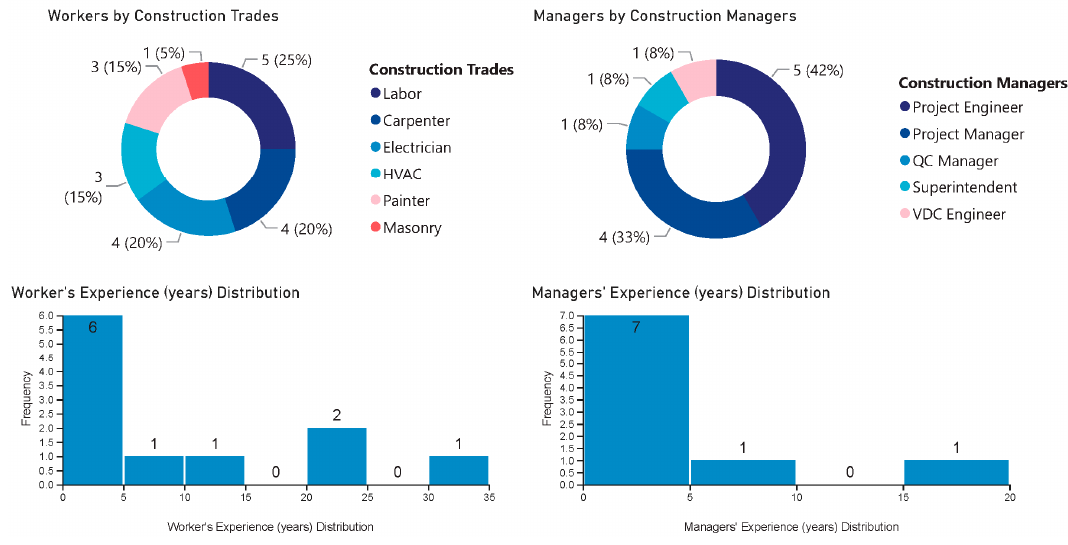
Figure 9. Description of survey subjects. Table 5. Evaluation of wearable